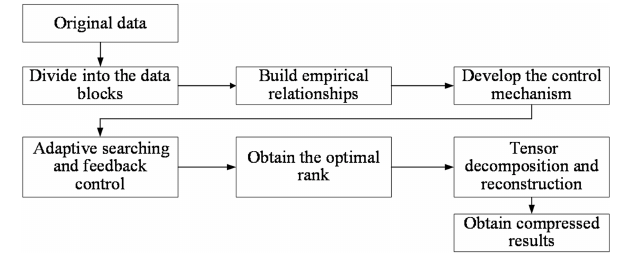
Figure 1. Overall framework of the basic